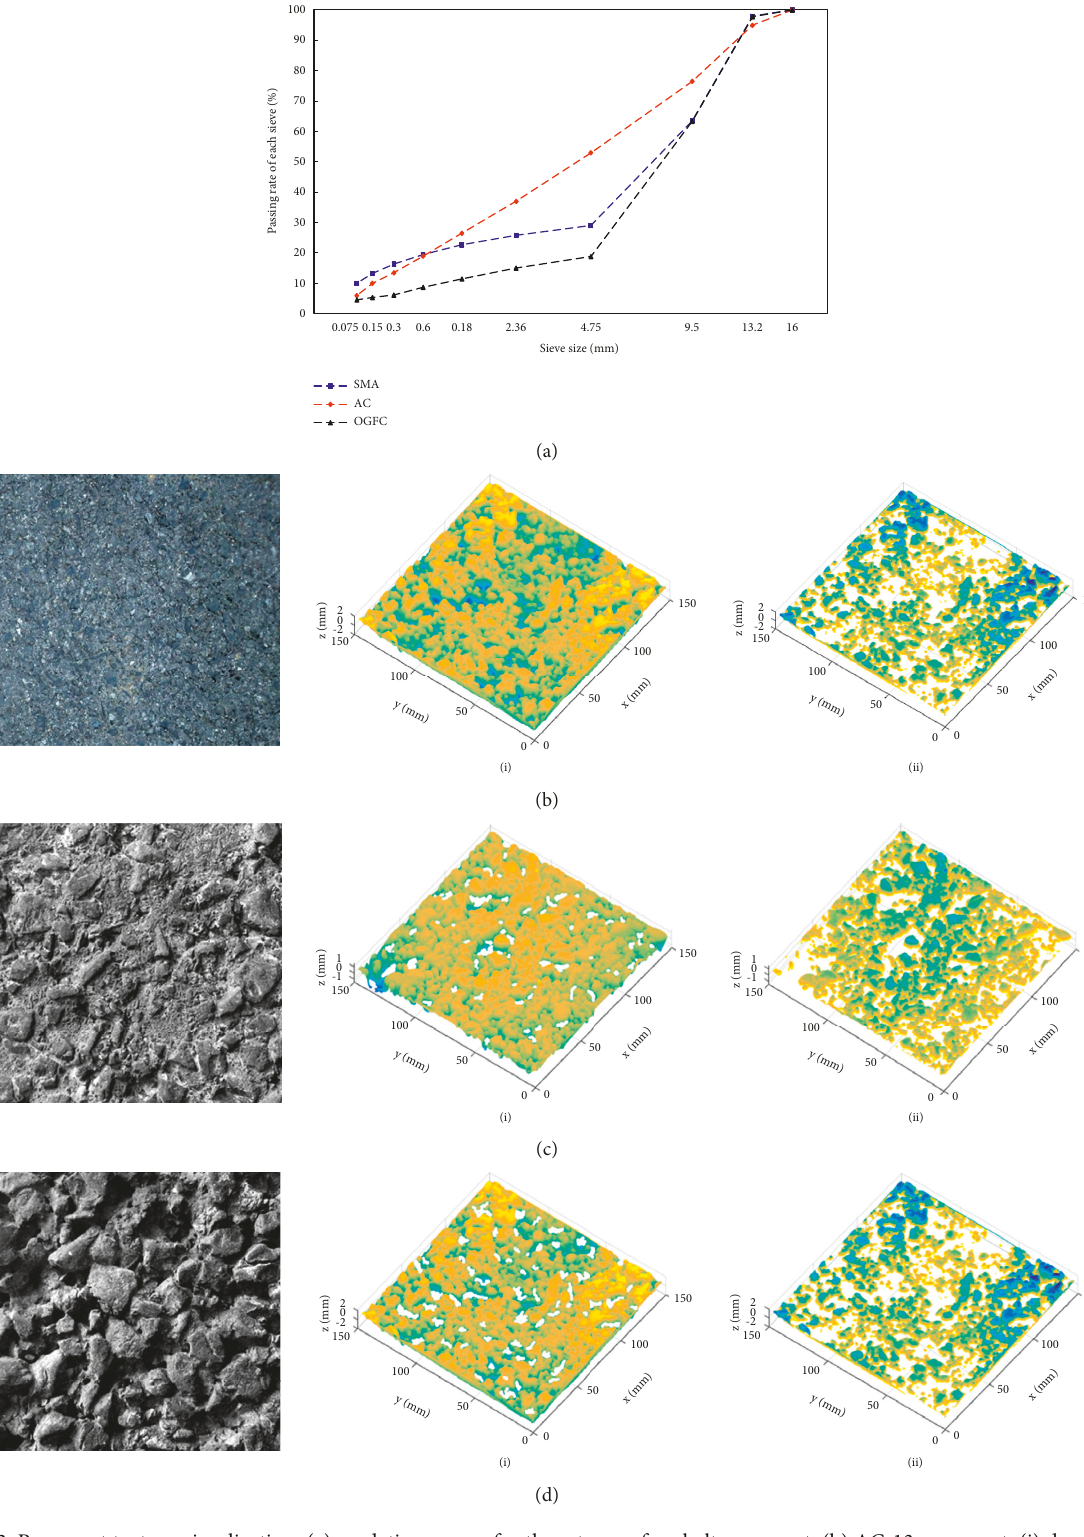
Figure 3: Pavement texture visualization: (a) gradation curves for three types of asphalt pavement; (b) AC-13 pavement, (i) dry condition and (ii) wet condition; (c) SMA-13 pavement, (i) dry condition and (ii) wet condition; (d) OGFC-13 pavement; (i) dry condition and (ii) wet